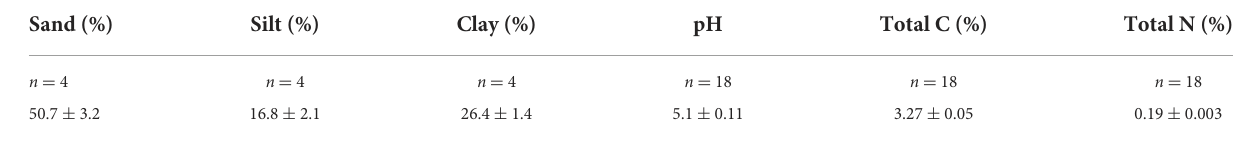
TABLE 2 Baseline soil